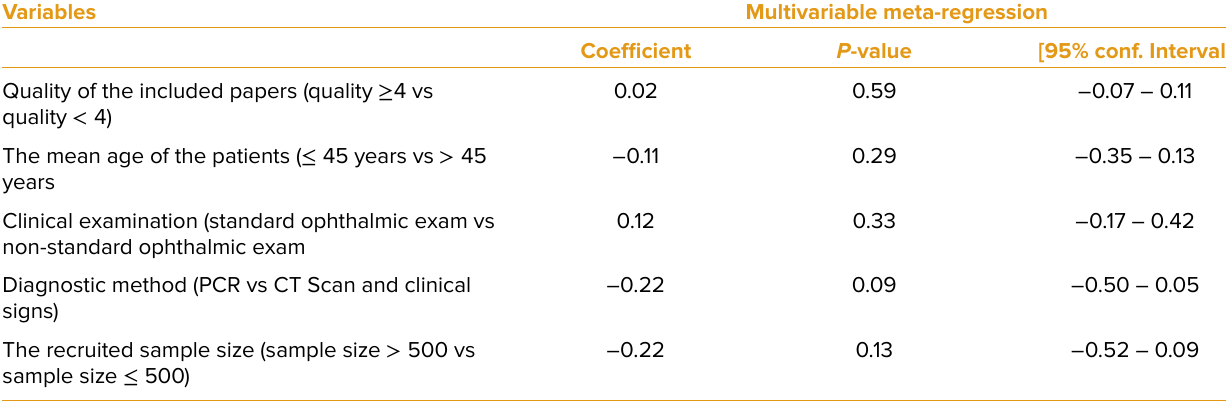
Table 3. Meta-regression analysis of the effect of the factors on the ocular manifestations of the COVID-19 patients Variables Multivariable